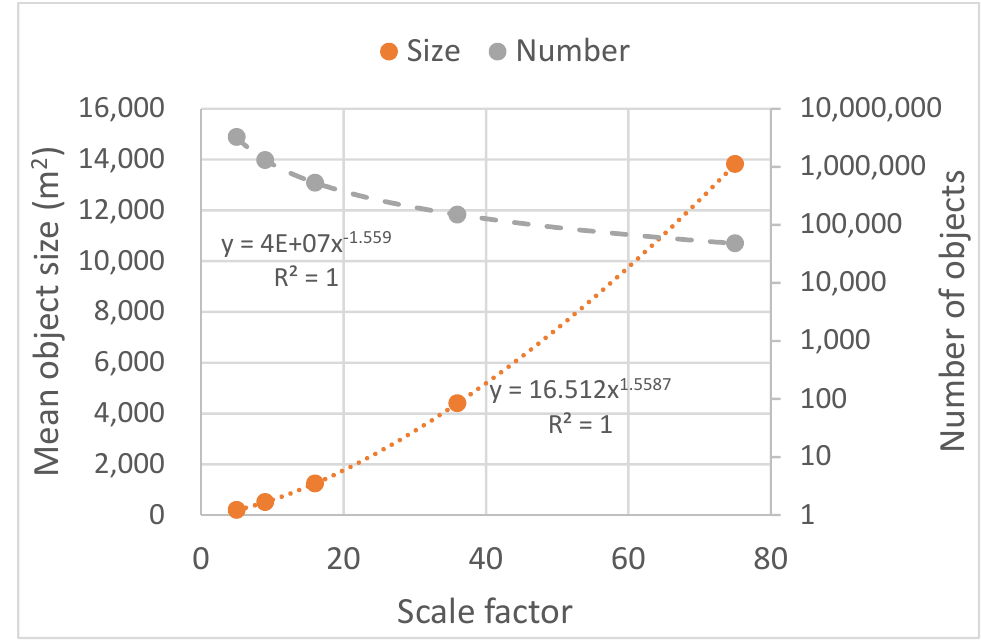
Figure 2. Mean object sizes (equivalent to the functional scales) and number of objects for the optimal scale factors detected with FNEA in the experimental Sentinel-2 image subset.